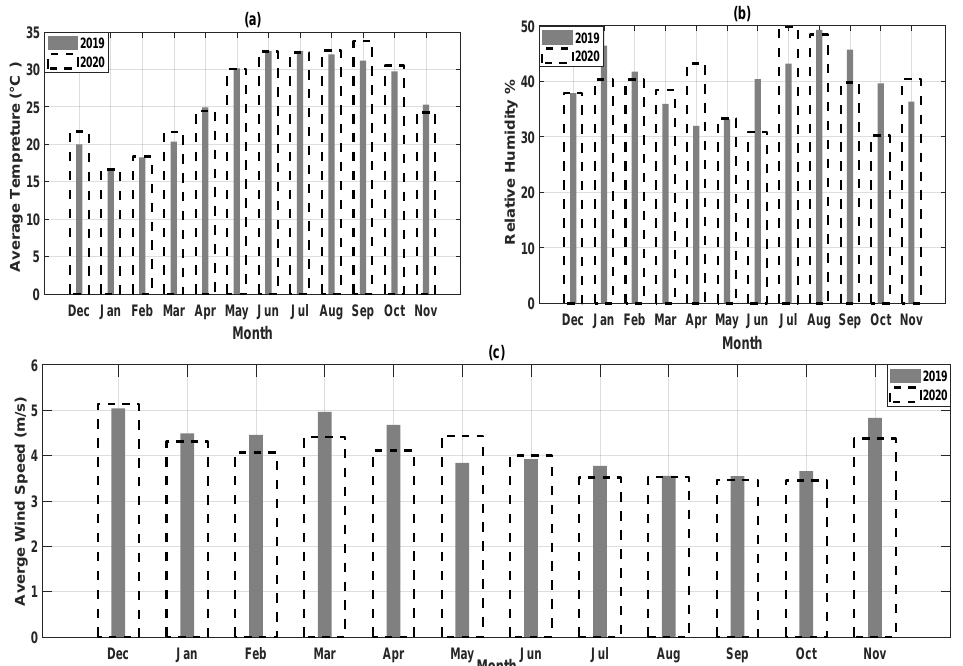
Figure 3. ( a ) Monthly Average Temperature, ( b ) Monthly Average Humidity, and ( c ) Monthly Average Wind